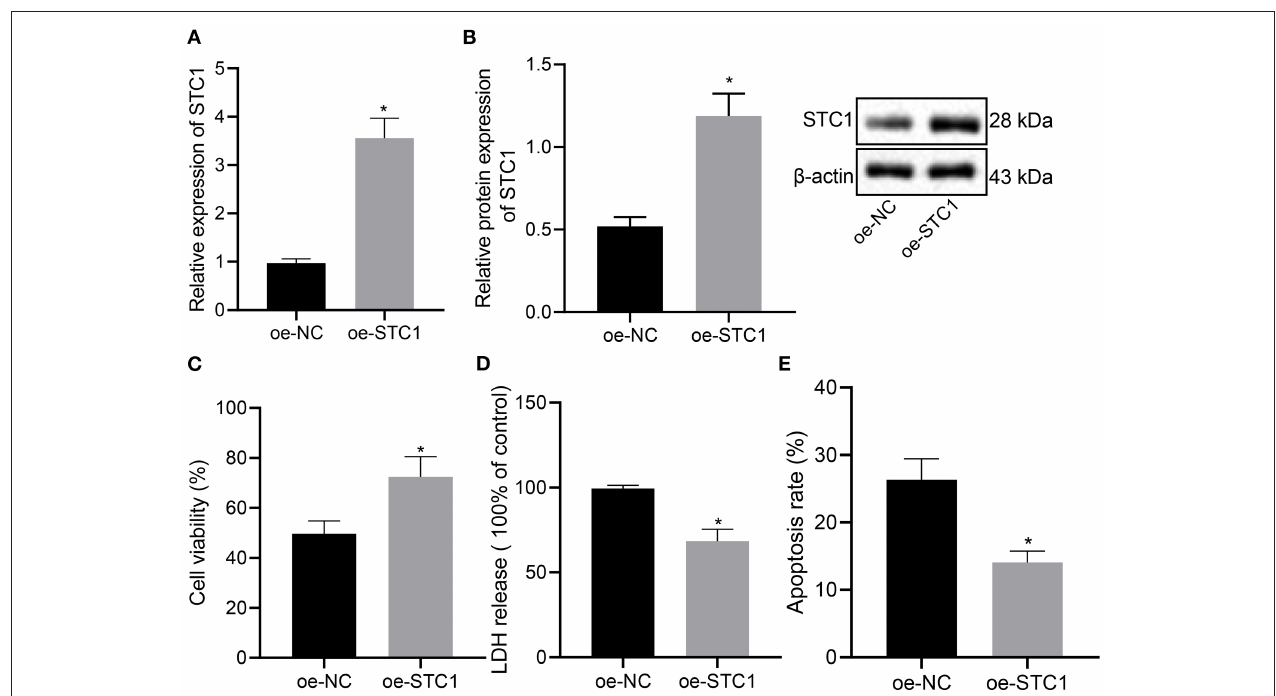
FIGURE 3 | STC1 overexpression reduces the toxicity and apoptosis of hippocampal neurons induced by CORT. (A) STC1 mRNA expression in hippocampal neurons induced by CORT determined by RT-qPCR. (B) STC1 protein expression in hippocampal neurons induced by CORT measured by Western blot assay. (C) viability of hippocampal neurons induced by CORT. (D) LDH activity in hippocampal neurons induced by CORT. (E) apoptosis of hippocampal neurons induced by CORT. * p < 0.05 vs. neurons treated with oe-NC. Cell experiment was repeated 3 times.